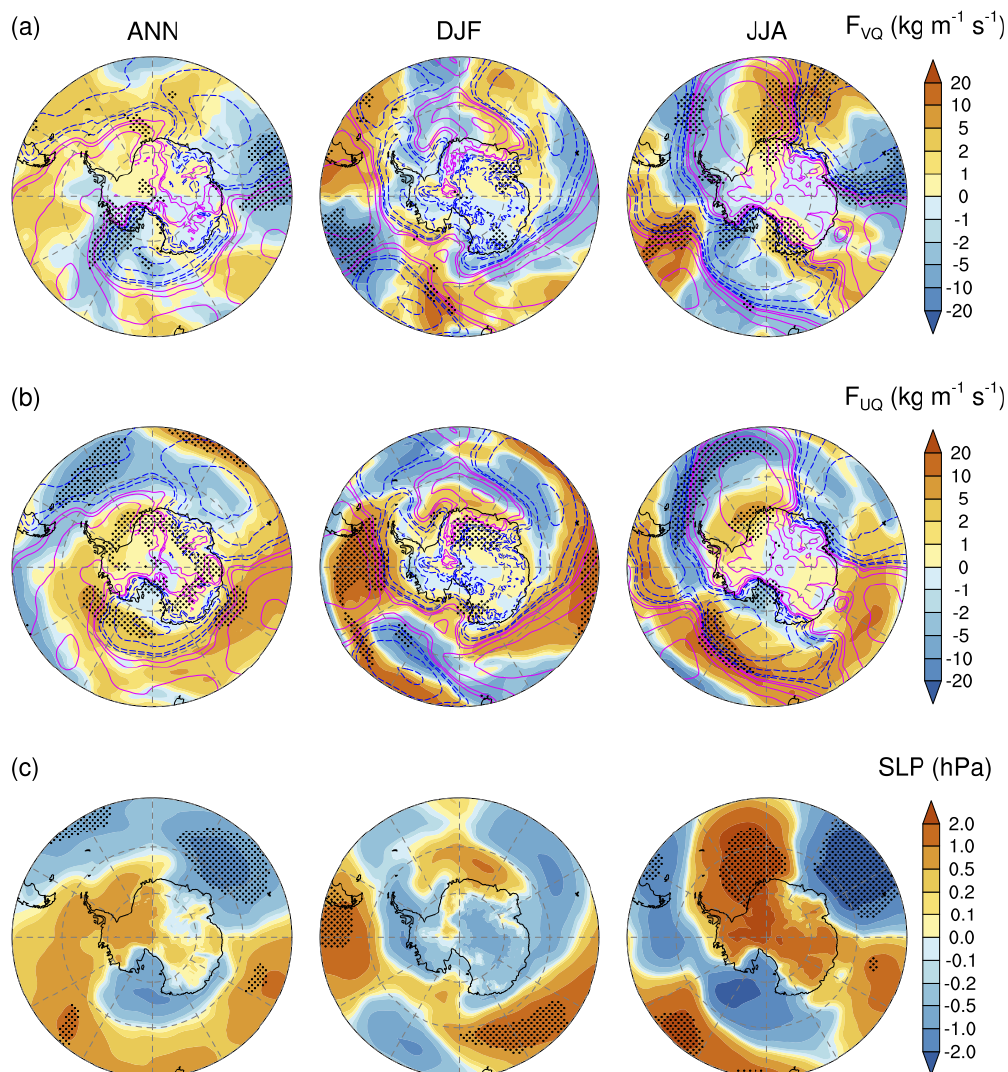
Figure 4. Spatial distribution of differences (low minus high) in annual (left) and seasonal (DJF and JJA) mean column-integrated (a) merid- ional and (b) zonal moisture flux and (c) sea level pressure (SLP). The superimposed contour lines represent SLP differences (magenta for positive and blue for negative, with the same intervals as in the SLP color bar in hPa). Stippling on the maps indicates that the differences are statistically significant at the 90% confidence level based on Student’s t